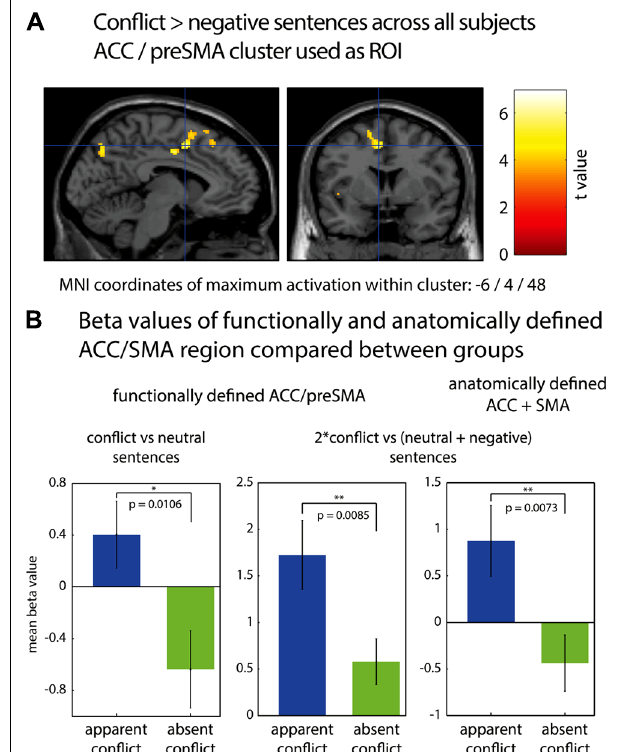
FIGURE 1 | (A) fMRI cluster including parts of ACC and preSMA, found to be activated during association to conflict-related sentences compared to negative sentences (Schmeing etal., 2013). (B) Comparison of mean beta values in functionally and anatomically defined regions of interest between group 1 (“apparent conflict”) and group 2 (“absent conflict”), using a one-tailed two-sample t -test. Bar plots indicate mean values with SEM. ∗ p < 0.05; ∗∗ p <